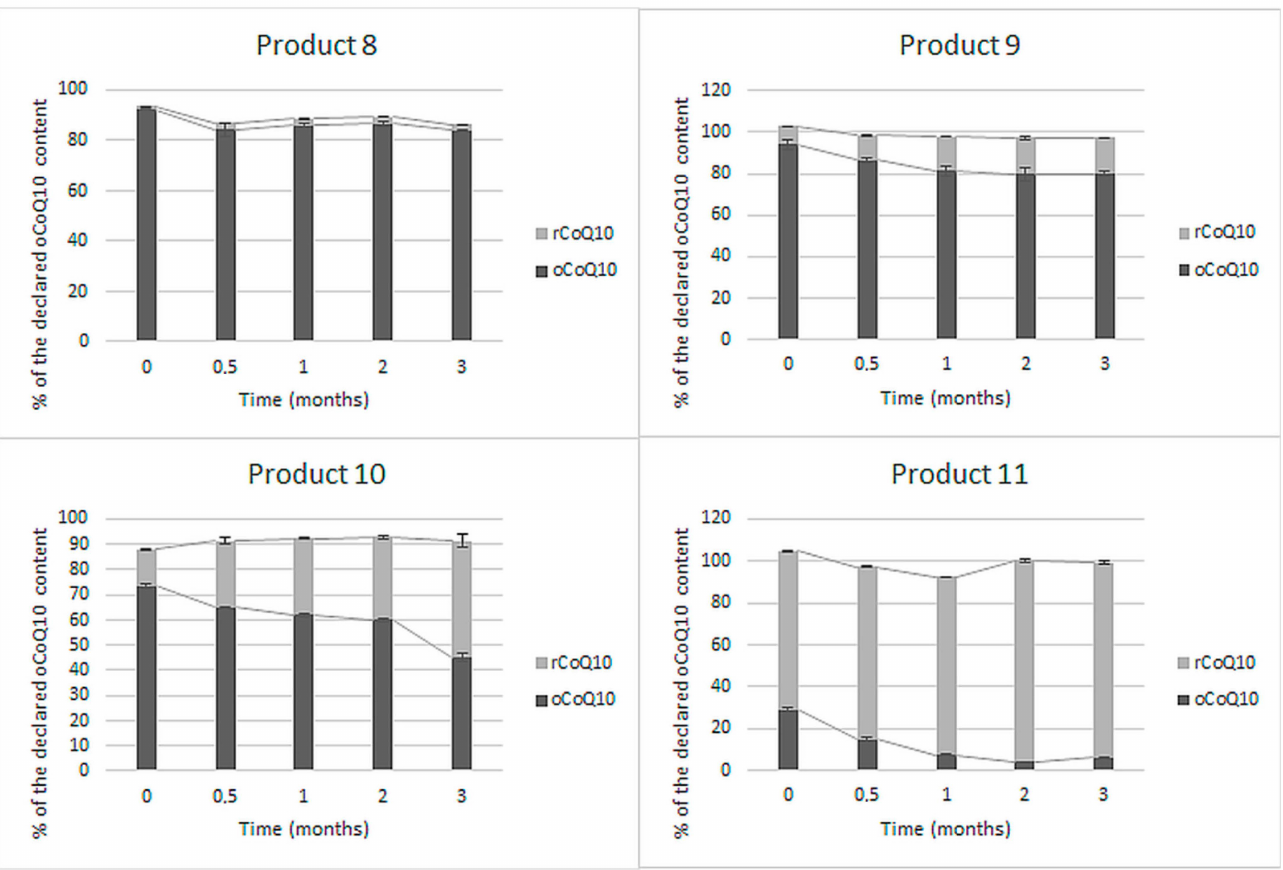
Figure 3. The stability of rCoQ10, oCoQ10, and total CoQ10 in the four tested finished products with specified oCoQ10 content after the accelerated stability